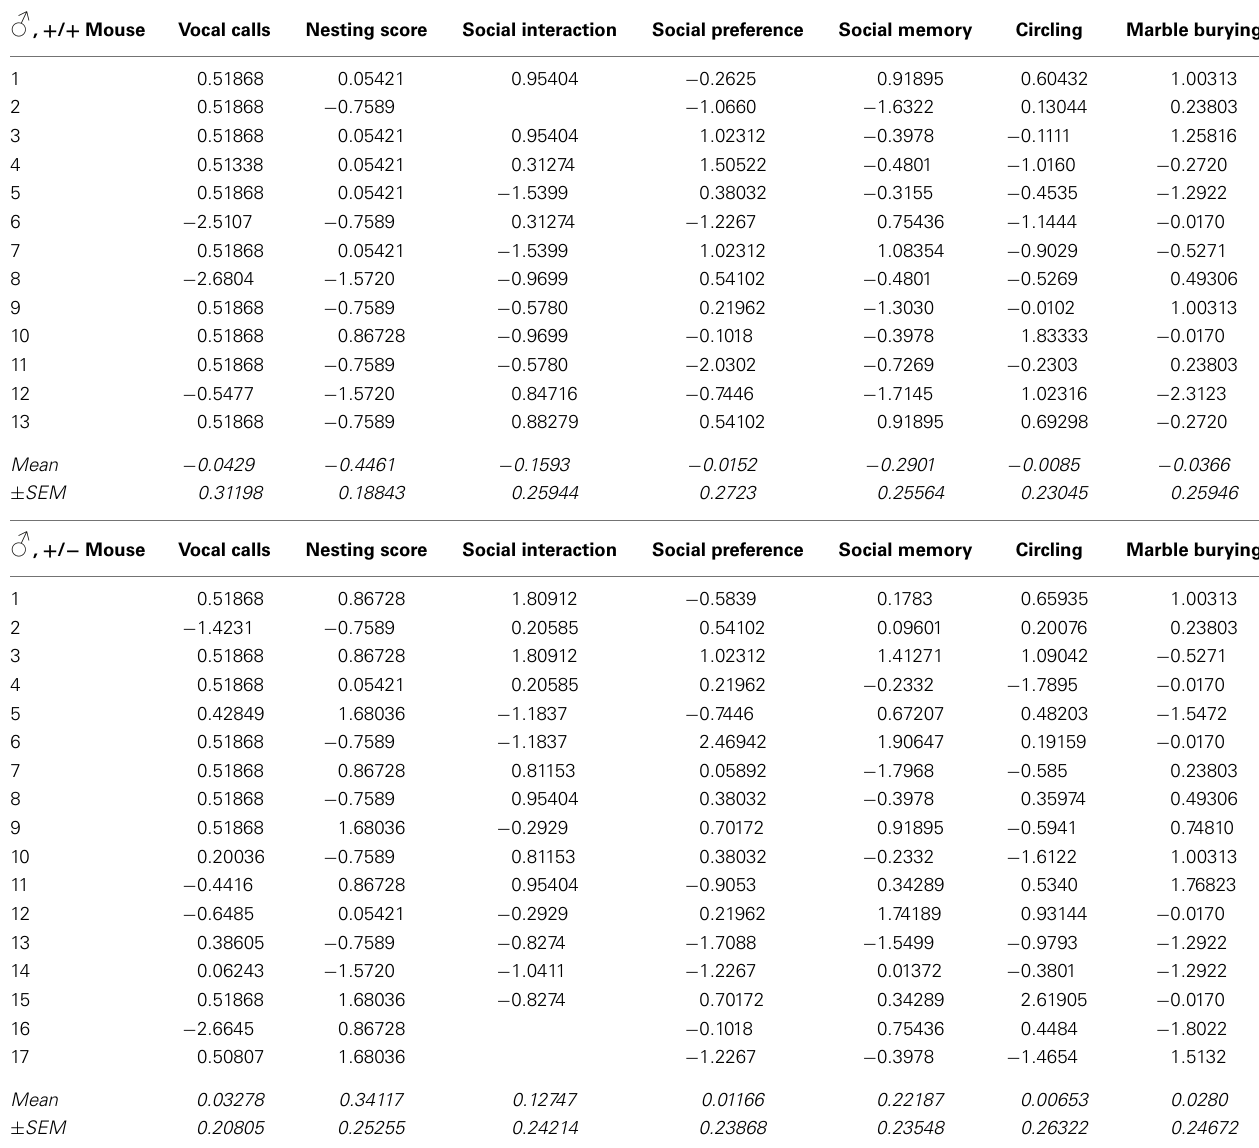
Table 2 | Individual z -standardized values for single readouts of the autism composite score of male Ambra1 + / + and Ambra1 + / − mice (see Figure